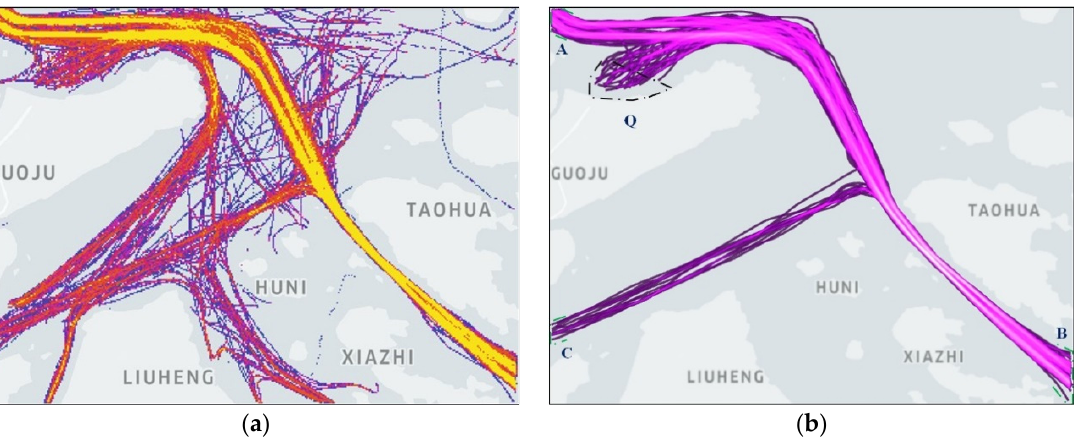
Figure 1. Vessel traffic patterns in Ningbo-Zhoushan waters. ( a ) AIS density map of vessel data within the geographic box ( b ) AIS tra ffi c fl ow pa tt ern distribution of vessels in prede fi ned areas.